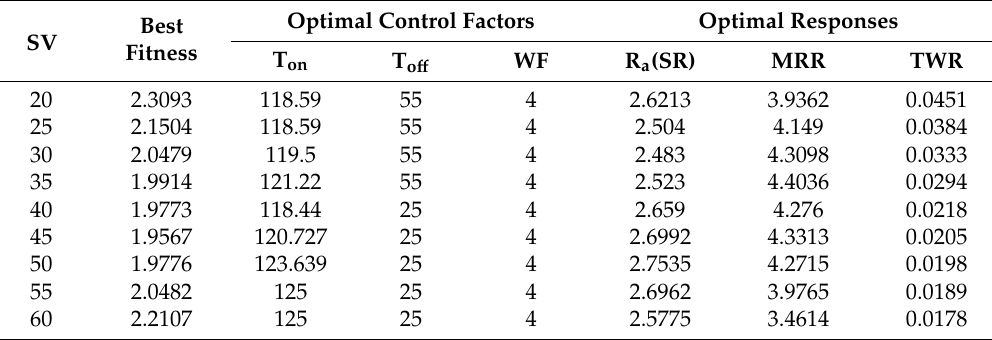
Figure 8. Comparison of Modified differential evolution (MDE) and differential evolution (DE) Convergence for servo voltage (SV) = 35 Volts. Table 3. Modified DE optimization results for WEDM characteristics.